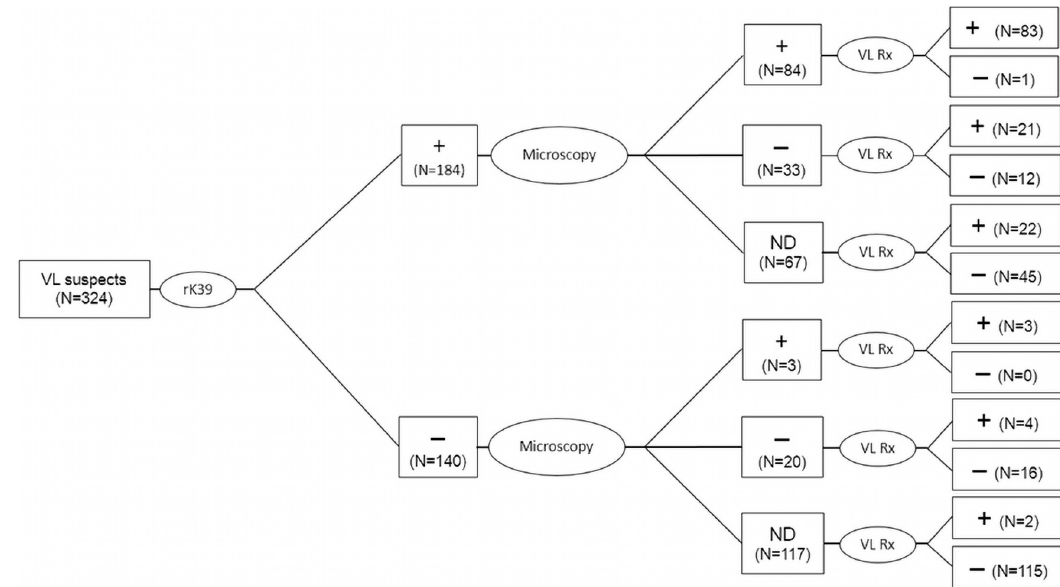
Fig 1. Flow chart of the clinical algorithm for management of visceral leishmaniasis. Abbreviations: VL = visceral leishmaniasis; ND = not done; N = number of cases; Rx = VL treatment.